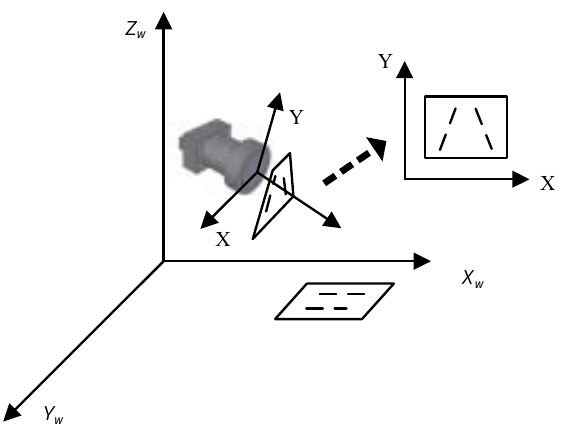
Figure 3. Transformation between the world coordinate and the camera coordinate.